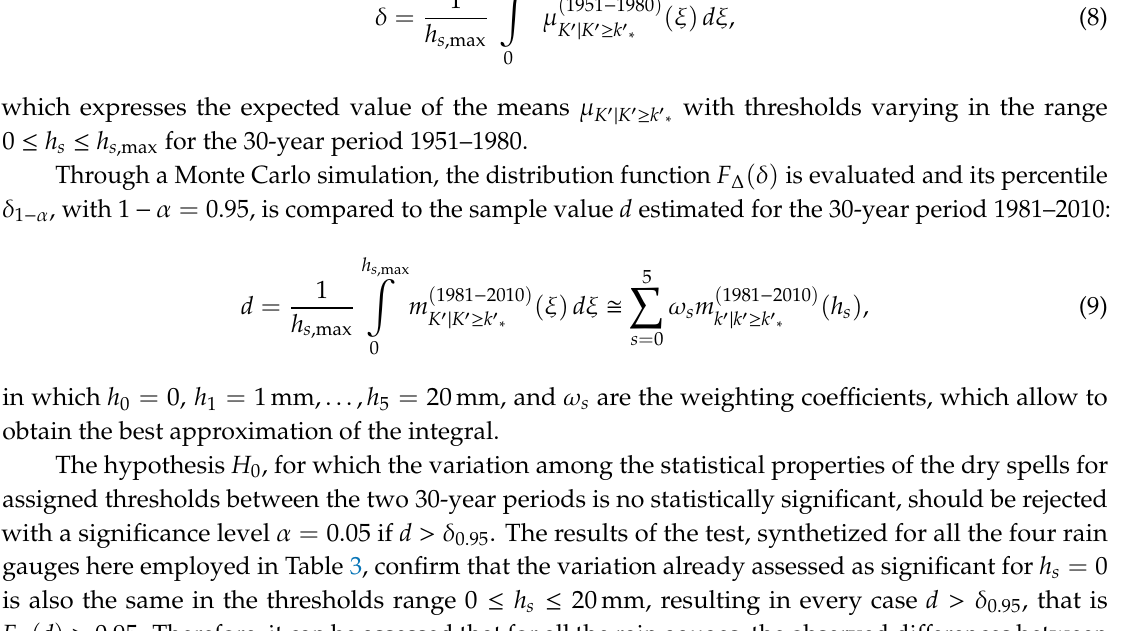
Table 3. Results of the test about the statistically significant di ff erences between the two 30-year periods. Rain Gauge d δ 0.95 F ∆ ( d ) H 0 Cosenza 18.34 18.28 0.954 Rejected Cassano allo Jonio 19.45 18.90 0.968 Rejected San Pietro in Guarano 17.72 17.43 0.961 Rejected Campotenese 16.32 15.44 0.982